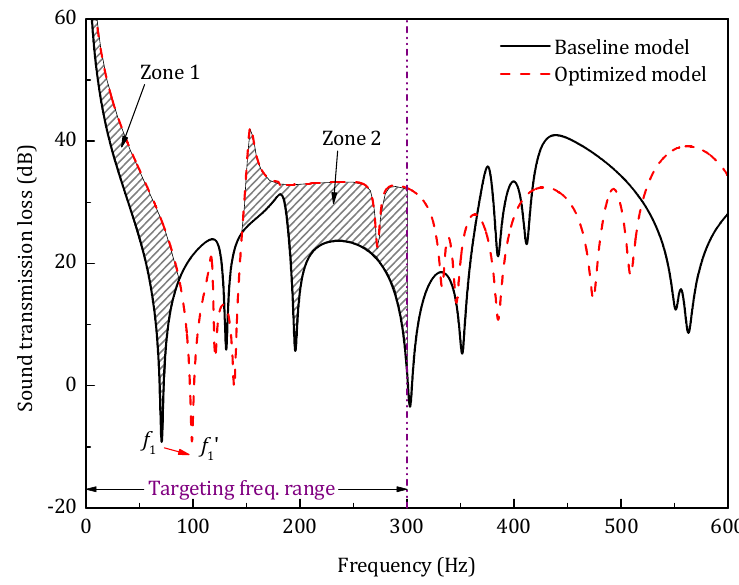
Figure 20. Sound transmission loss of the optimized model in low-frequency range.